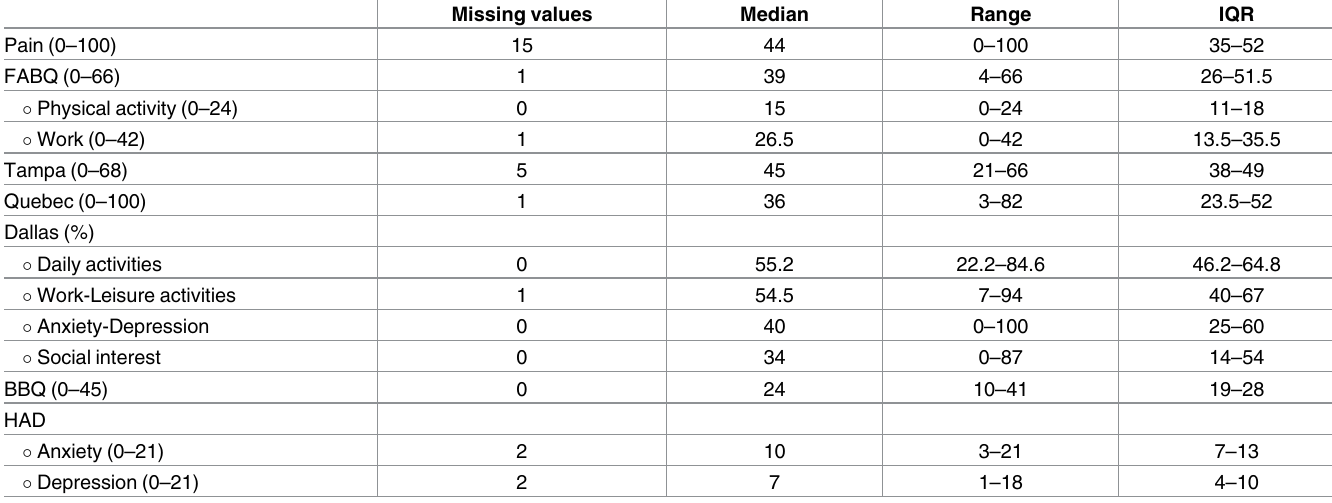
Table 1. LBP characteristics of the study population at the referencevisit